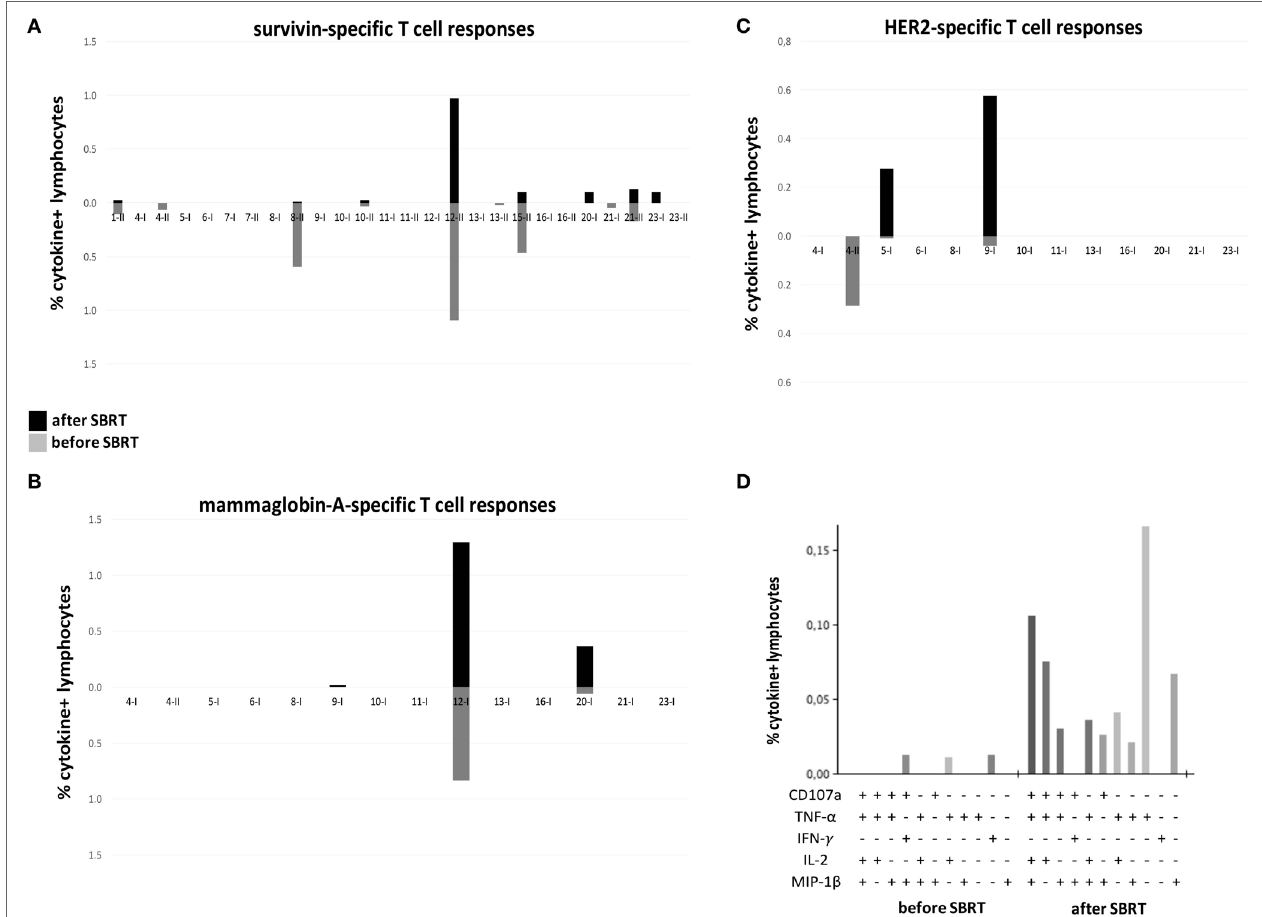
FigUre 1 | Tumor-specific T cell responses in oligometastatic breast cancer (BC) patients before and after SBRT. T cell responses against BC-associated antigens [survivin (a) ; mammaglobin-A (B) ; HER2 (c) ] were monitored through flow cytometry in oligometastatic BC patients before and after (1 month; 4 months for patients no. 5 and no. 8) SBRT. The percentage of cytokine + T cells was considered positive if at least doubled compared to the percentage of cytokine + T cells after stimulation with a negative peptide control (HIV). Graphs in panels (a–c) reported the sum of T-cells positive to at least one of the markers investigated (CD107a, TNF- α , INF- γ , IL-2, and MIP-1 β ). A cutoff of 0.01% was set up to discriminate a positive population. Each pair of histograms (gray, data before SBRT; black, data after SBRT) represents the analysis performed in a single patient, as reported below, after stimulation with MHC class-I (I)- or MHC class-II (II)-restricted peptides. (D) Representative histogram of Boolean analysis performed in patient no. 9 and showing polyfunctional T cells after stimulation with MHC class-I-restricted HER2-derived peptides, before and after SBRT. Each bar represents a population of T cells producing a distinct set of cytokines or expressing CD107a as reported